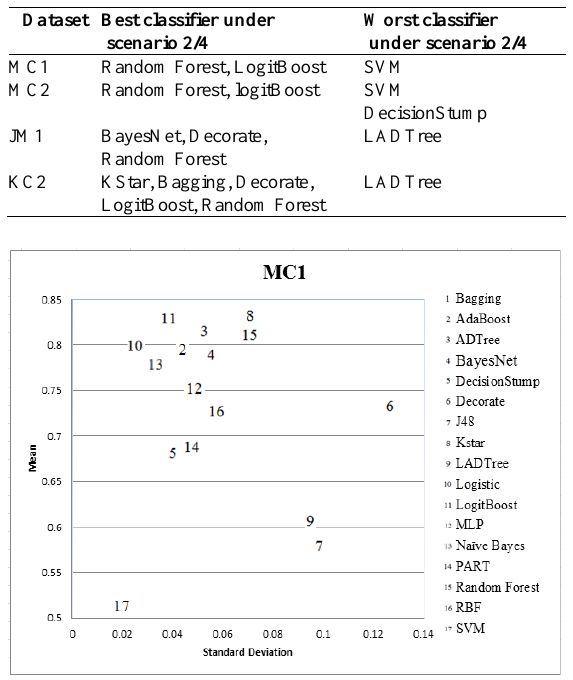
Figure 7. AUC mean value with 4 scenarios and deviation from mean value in MC1 dataset classification.